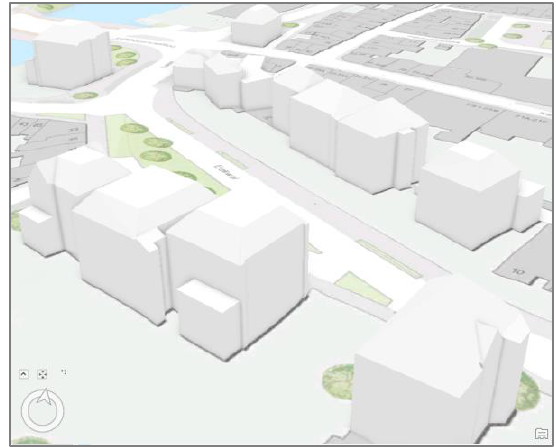
Figure 8. The final result of the generated 3D building model.